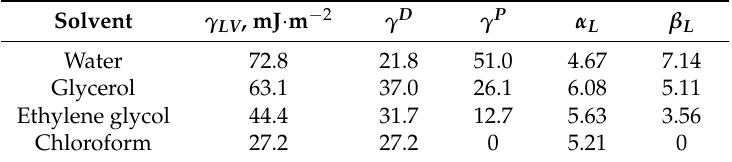
Table 4. Surface parameters of several solvents used to measure the contact angle.